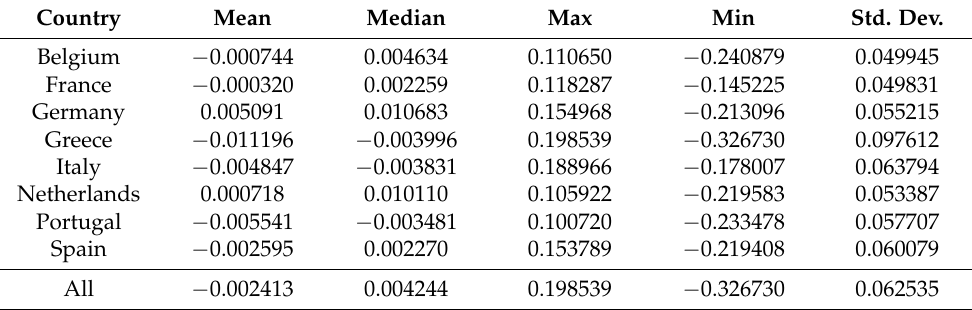
Table A1. Descriptive statistics for monthly returns by country.